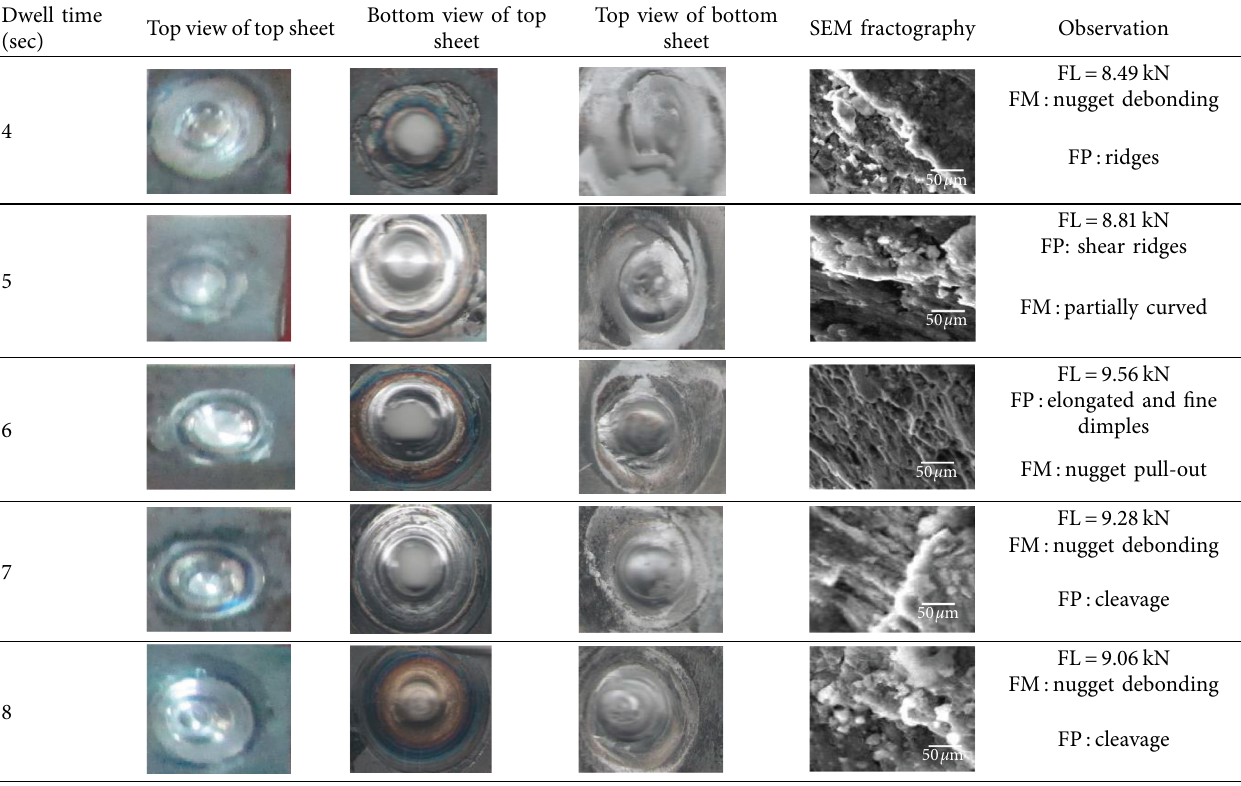
Table 5: Influence of dwell time on failure